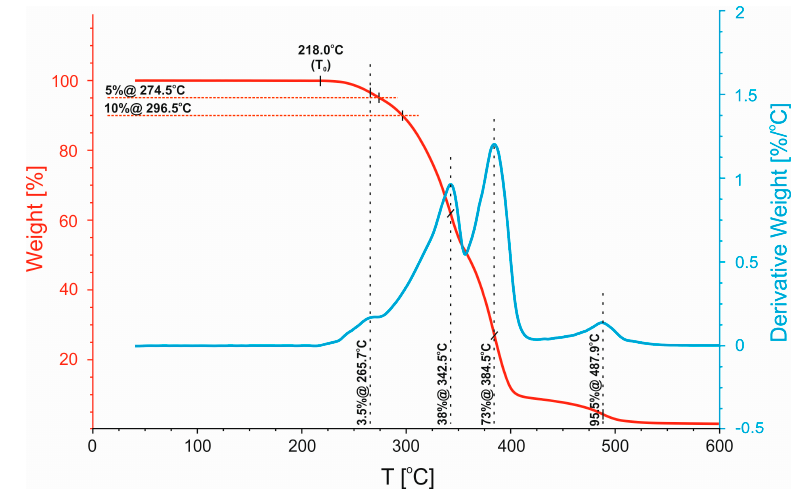
Figure 8. Non-isothermal analysis of TG and DTG thermograms of the 50/50 PP/PBT blend containing PBT–DLA copolymer.